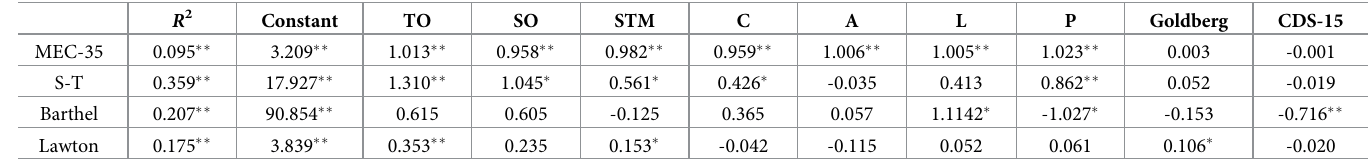
Table 5. Regression